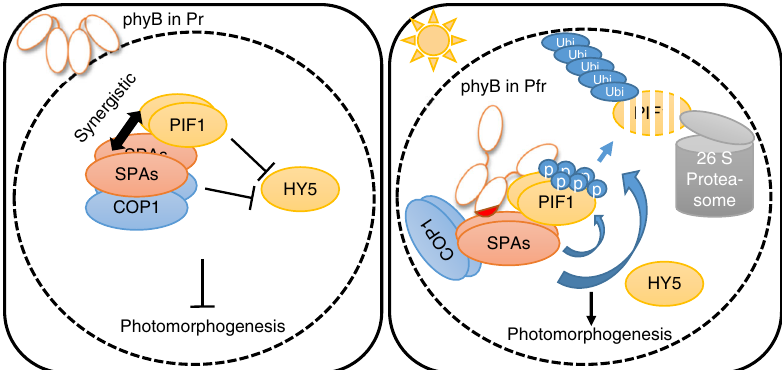
Fig. 9 Model showing phyB-SPA1-COP1-PIF1 relationships in dark and light conditions. In darkness, inactive Pr form of phyB is present in the cytoplasm, while COP1-SPA complex together with PIF1 as a co-factor induces degradation of positively acting transcription factors (HY5/HFR1 and possibly others). However, upon light exposure, activated Pfr form of phyB translocates into the nucleus and interacts with PIF1 as well as SPA1 to trigger rapid phosphorylation of PIF1. phyB interacts with PIFs mostly through its N-terminal domain, while its extreme C-terminal 80 amino acids (shown as a red patch) are necessary for SPA1 interaction. By stabilizing the phyB-SPA1-PIF1 tripartite complex, phyB can initiate the light-induced phosphorylation of PIF1 by SPA1 kinase. Phosphorylated PIF1 is then recognized by the CUL4 COP1-SPA E3 ubiquitin ligase for rapid poly-ubiquitination and subsequent degradation through the 26S proteasome. Degradation of PIFs and stabilization of HY5 result in promotion of